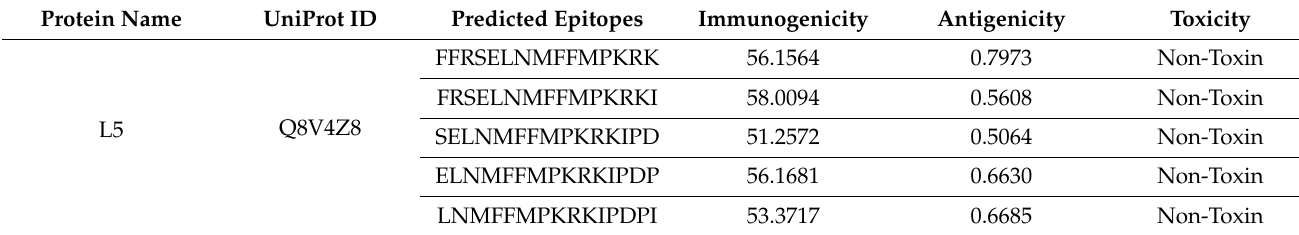
Table 3. The immunogenicity, antigenicity, and toxicity of finalized MHC class-II T-cell epitopes.